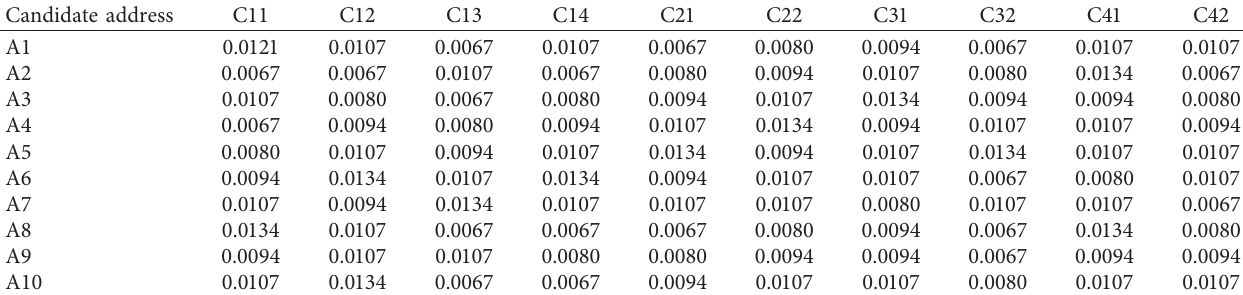
Table 2: Normalized weighted evaluation matrix result